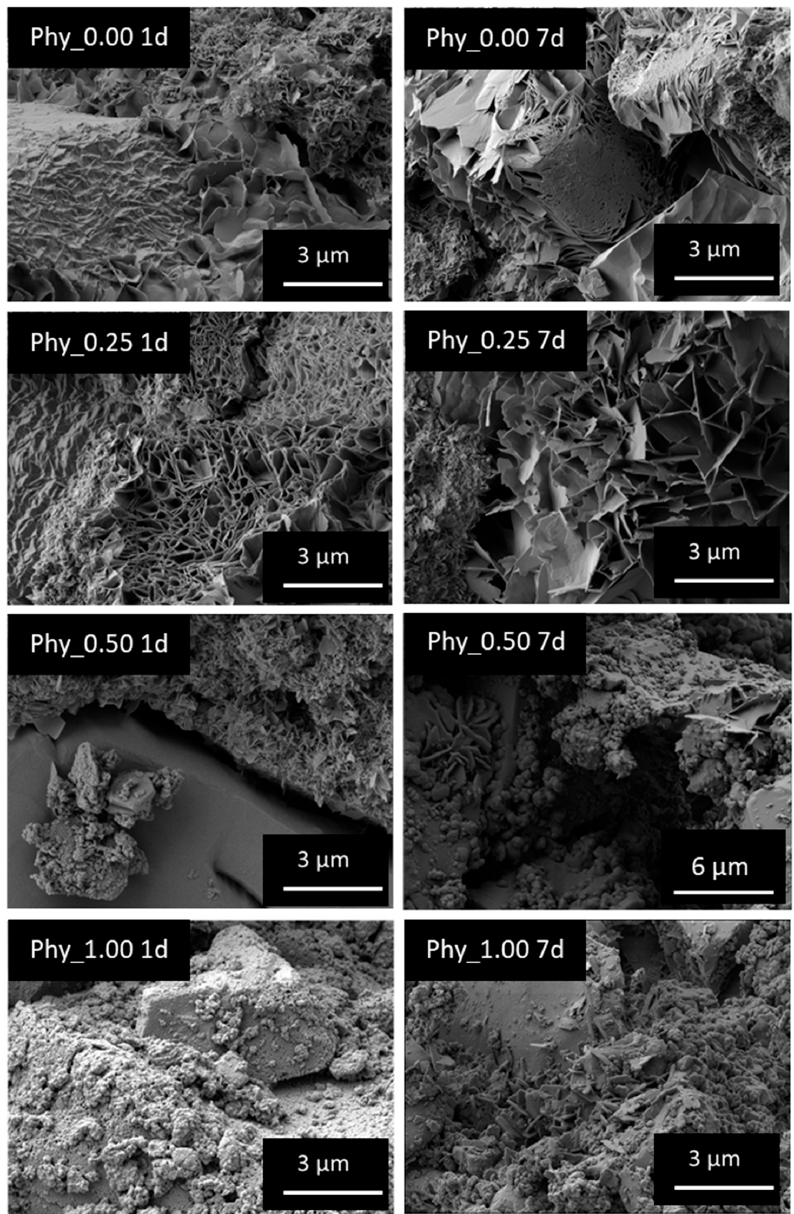
Figure 11. CDHA crystals of the mixtures Phy_0.00, Phy_0.25, Phy_0.50 and Phy_1.00 grown for 1 d and 7 d at 37 °C and 100% humidity, visualized with the SEM. All samples have been observed on different areas, and representative images were selected for presentation.